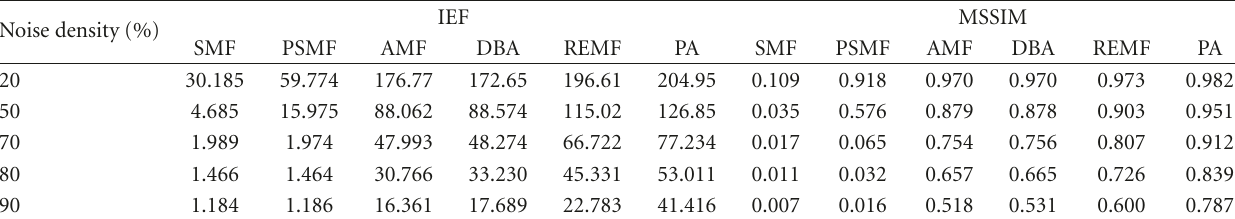
Table 4: IEF and MSSIM for various filters for boat image at di ff erent noise densities.